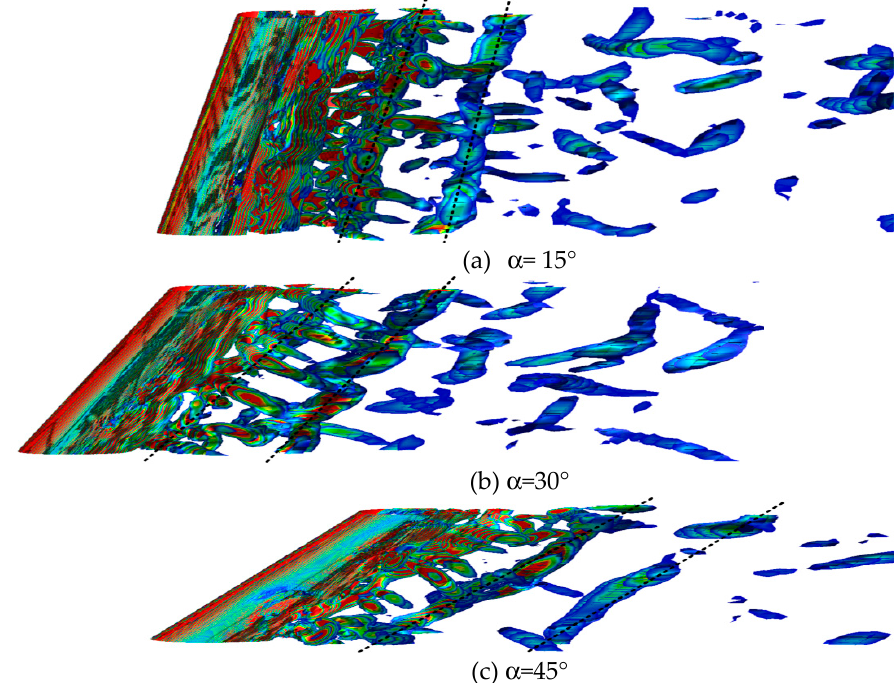
Figure 4. Vortex structure under periodic boundary condition on two end-plate walls.